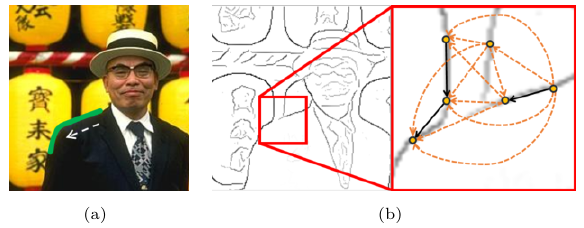
Fig. 3 Graph construction. (a) A coherence stroke (green) drawn by the user; direction shown by white arrow. (b) (Right) corresponding digraph based on the detailed line drawing (left). Each vertex represents a line segment. Real edges: black arrows. Virtual edges: orange arrows. Directions of edges are consistent with the direction of the input